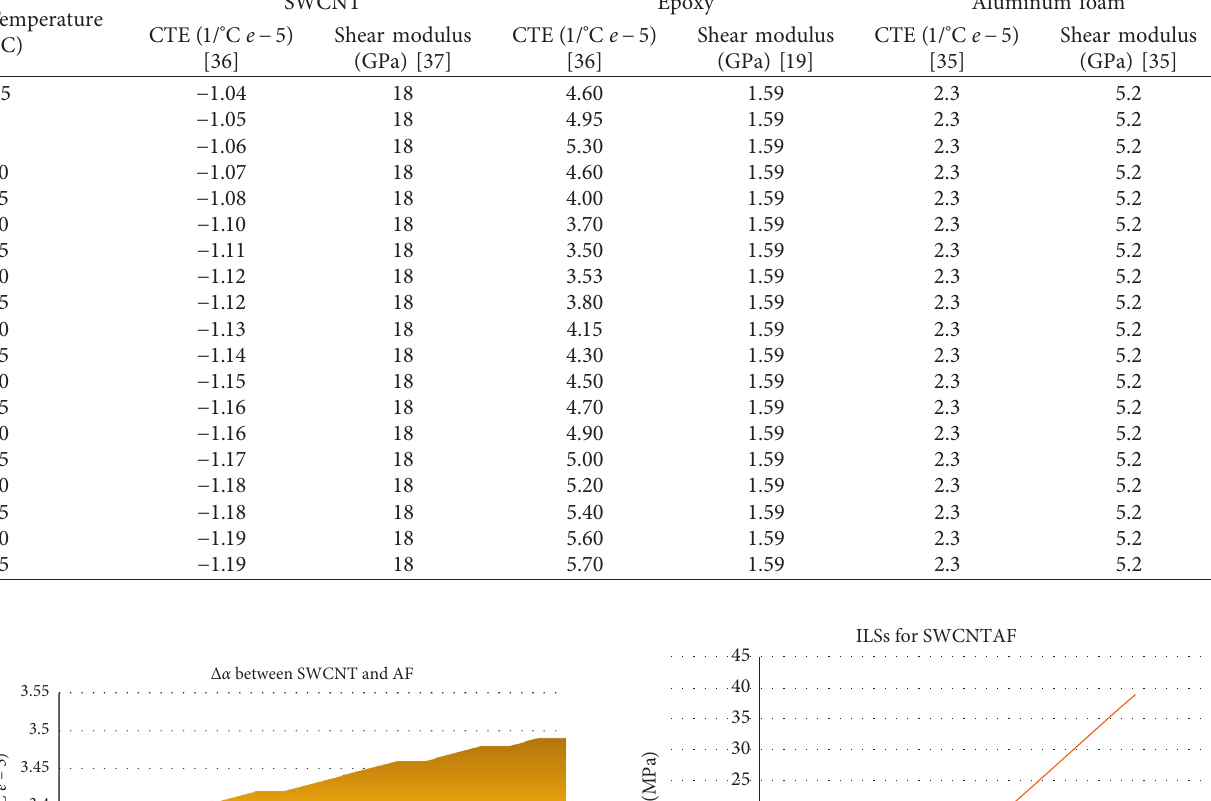
Table 5: CTEs and shear modulus of SWCNT, epoxy, and aluminum foam at temperature range of − 5 to 80 ° C. Temperature